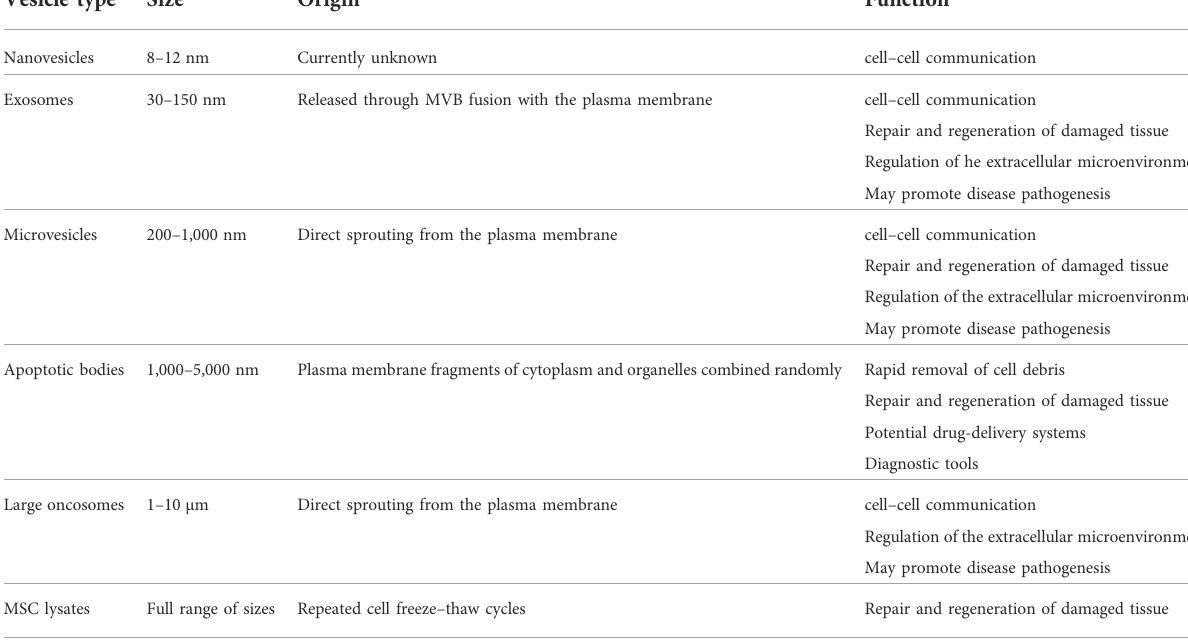
TABLE 3 Characteristics of different EVs and MSC